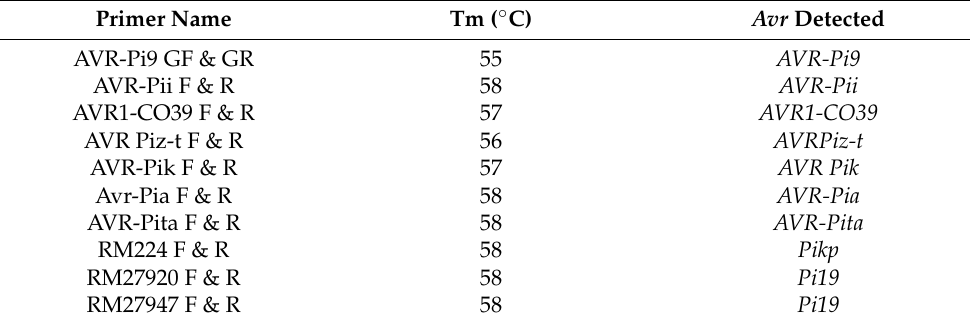
Table 4. List of molecular markers to identify Avr